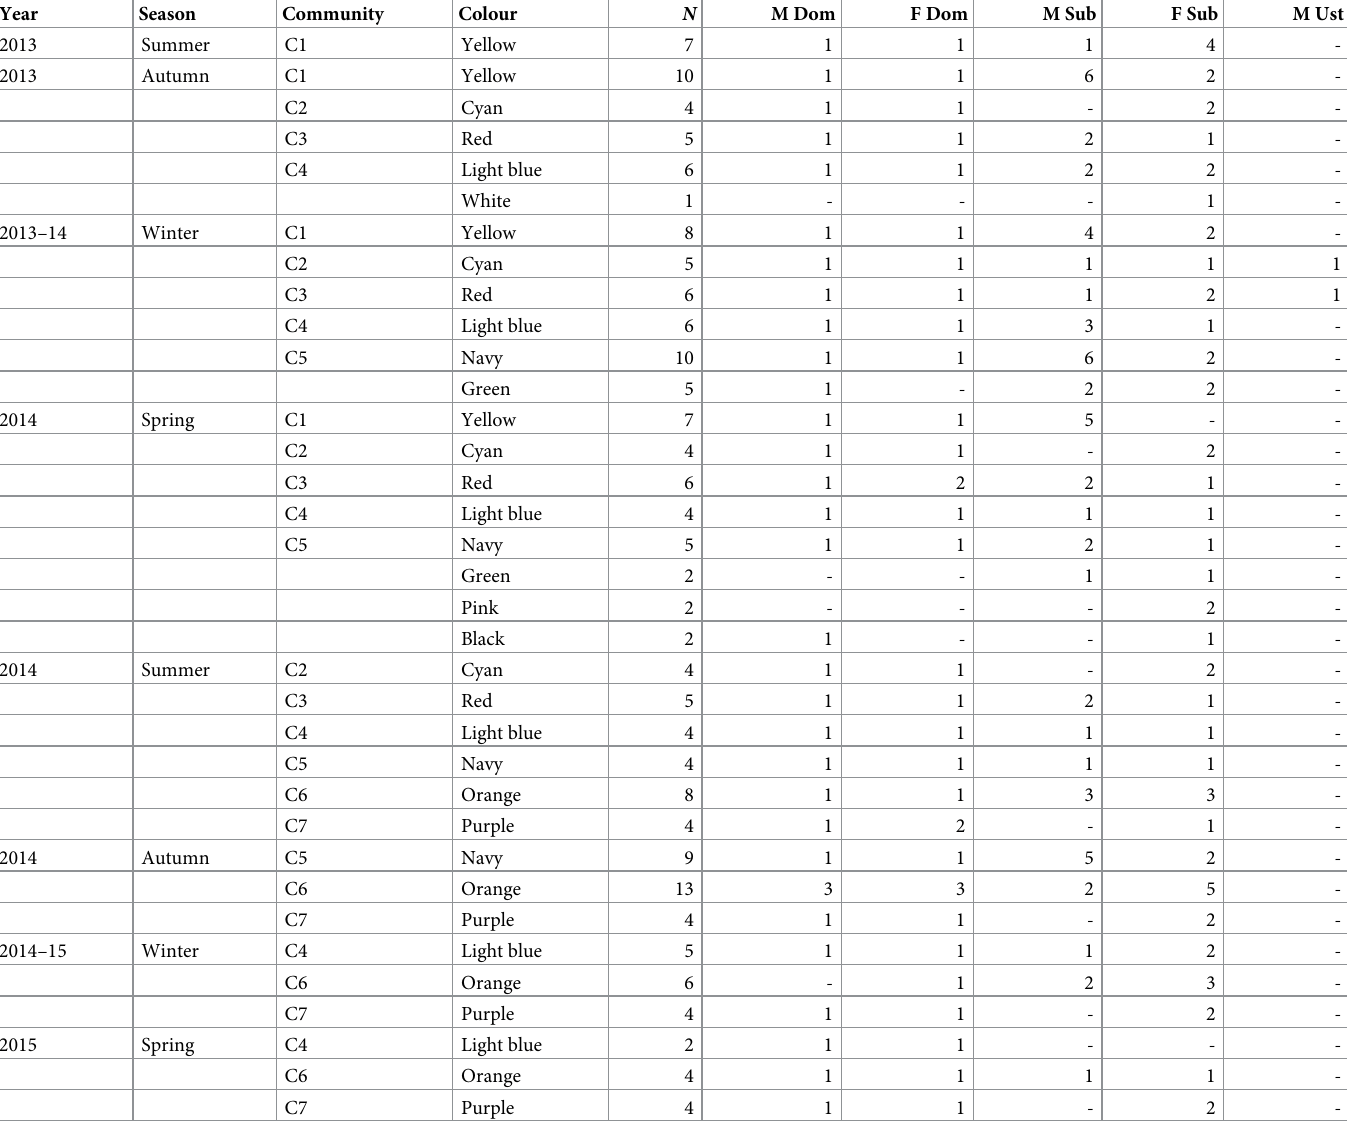
Table 3. Membership of communities delineated in each season and year separately (season-year